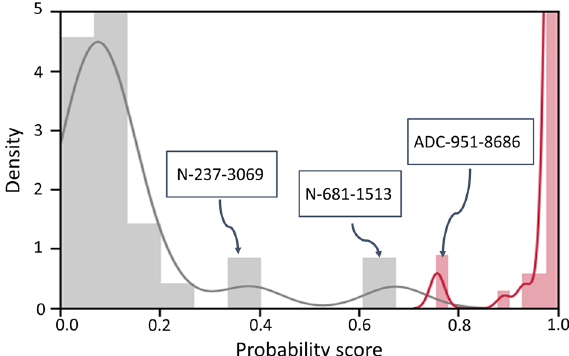
Figure 6. Slide-based cancer probabilities of the three samples, N-S12-13682, N-S12-15479, and ADC-S12- 13080, among the distribution of the entire GNUH lung cancer dataset by HipoMap. The distribution of the normal slides is in gray, whereas the probabilities of cancer are in red.